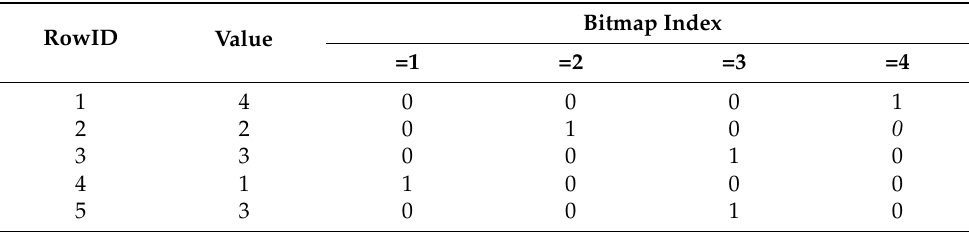
Table 1. Bitmap index